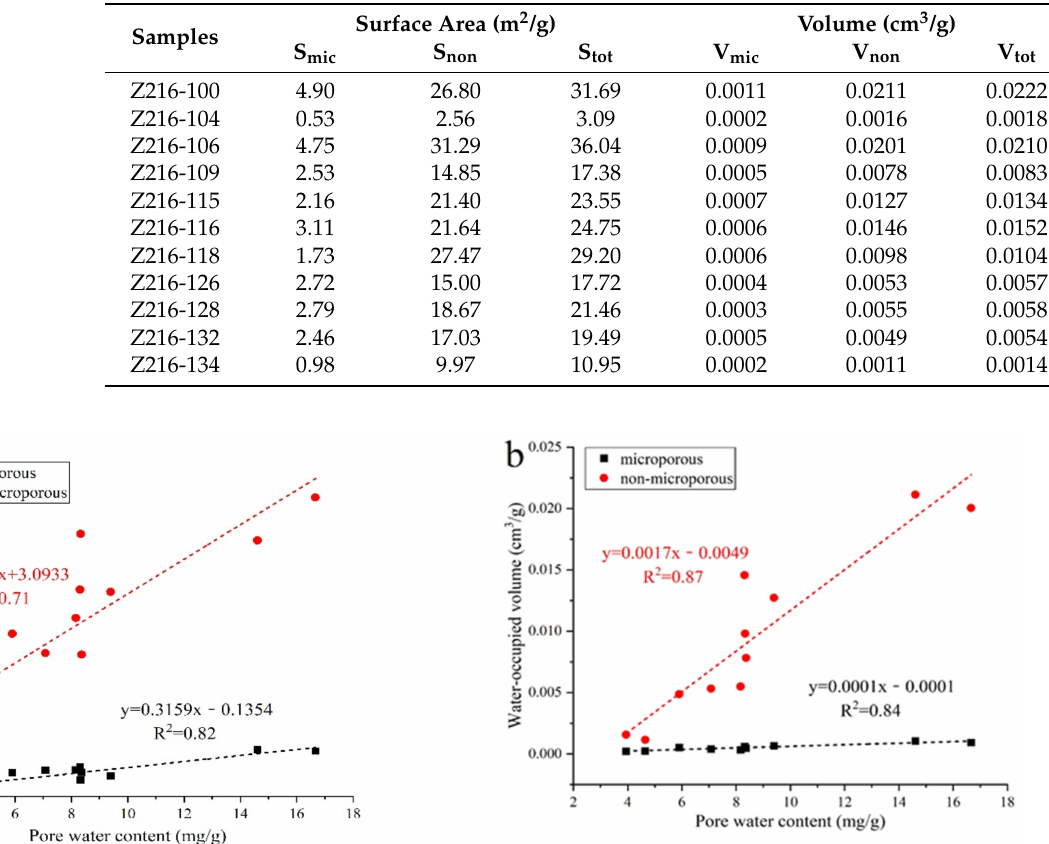
Table 4. Water-occupied pore surface areas and volumes of the studied deep shale samples.